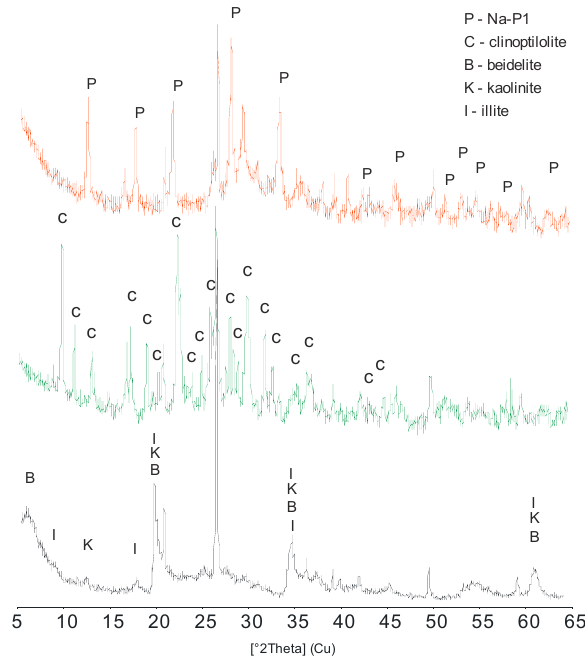
Figure 2. X-ray diffraction (XRD) patterns of the original clay deposit ( black ), clinoptilolitic tuff ( green ) and zeolite Na-P1 ( red ).